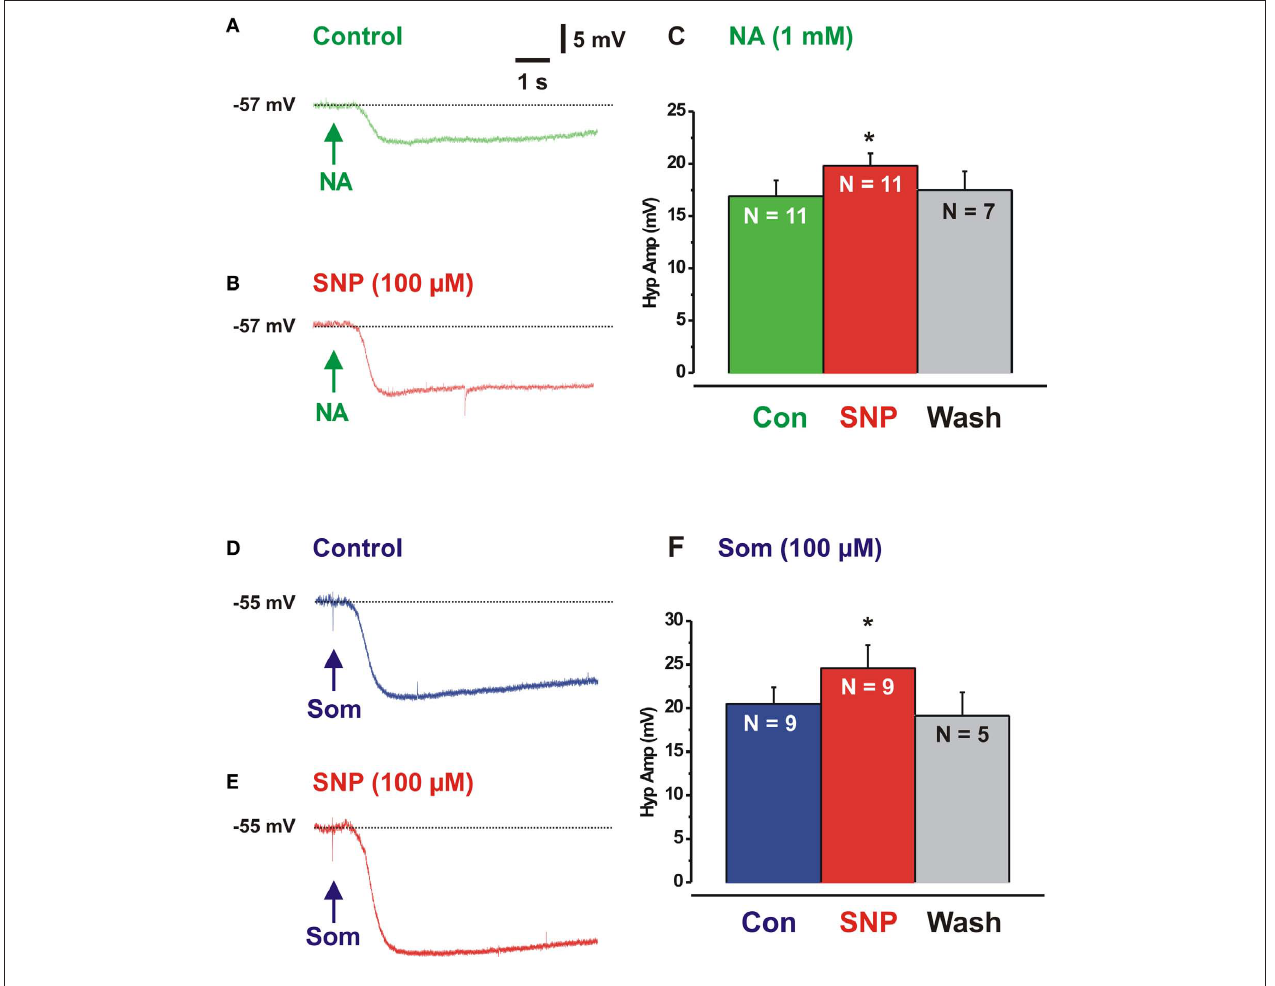
FIgurE 3 | Sodium nitroprusside enhances responses evoked by noradrenaline and somatostatin. (A) Hyperpolarization evoked by local application of noradrenaline (NA, at arrow, green), (B) response evoked